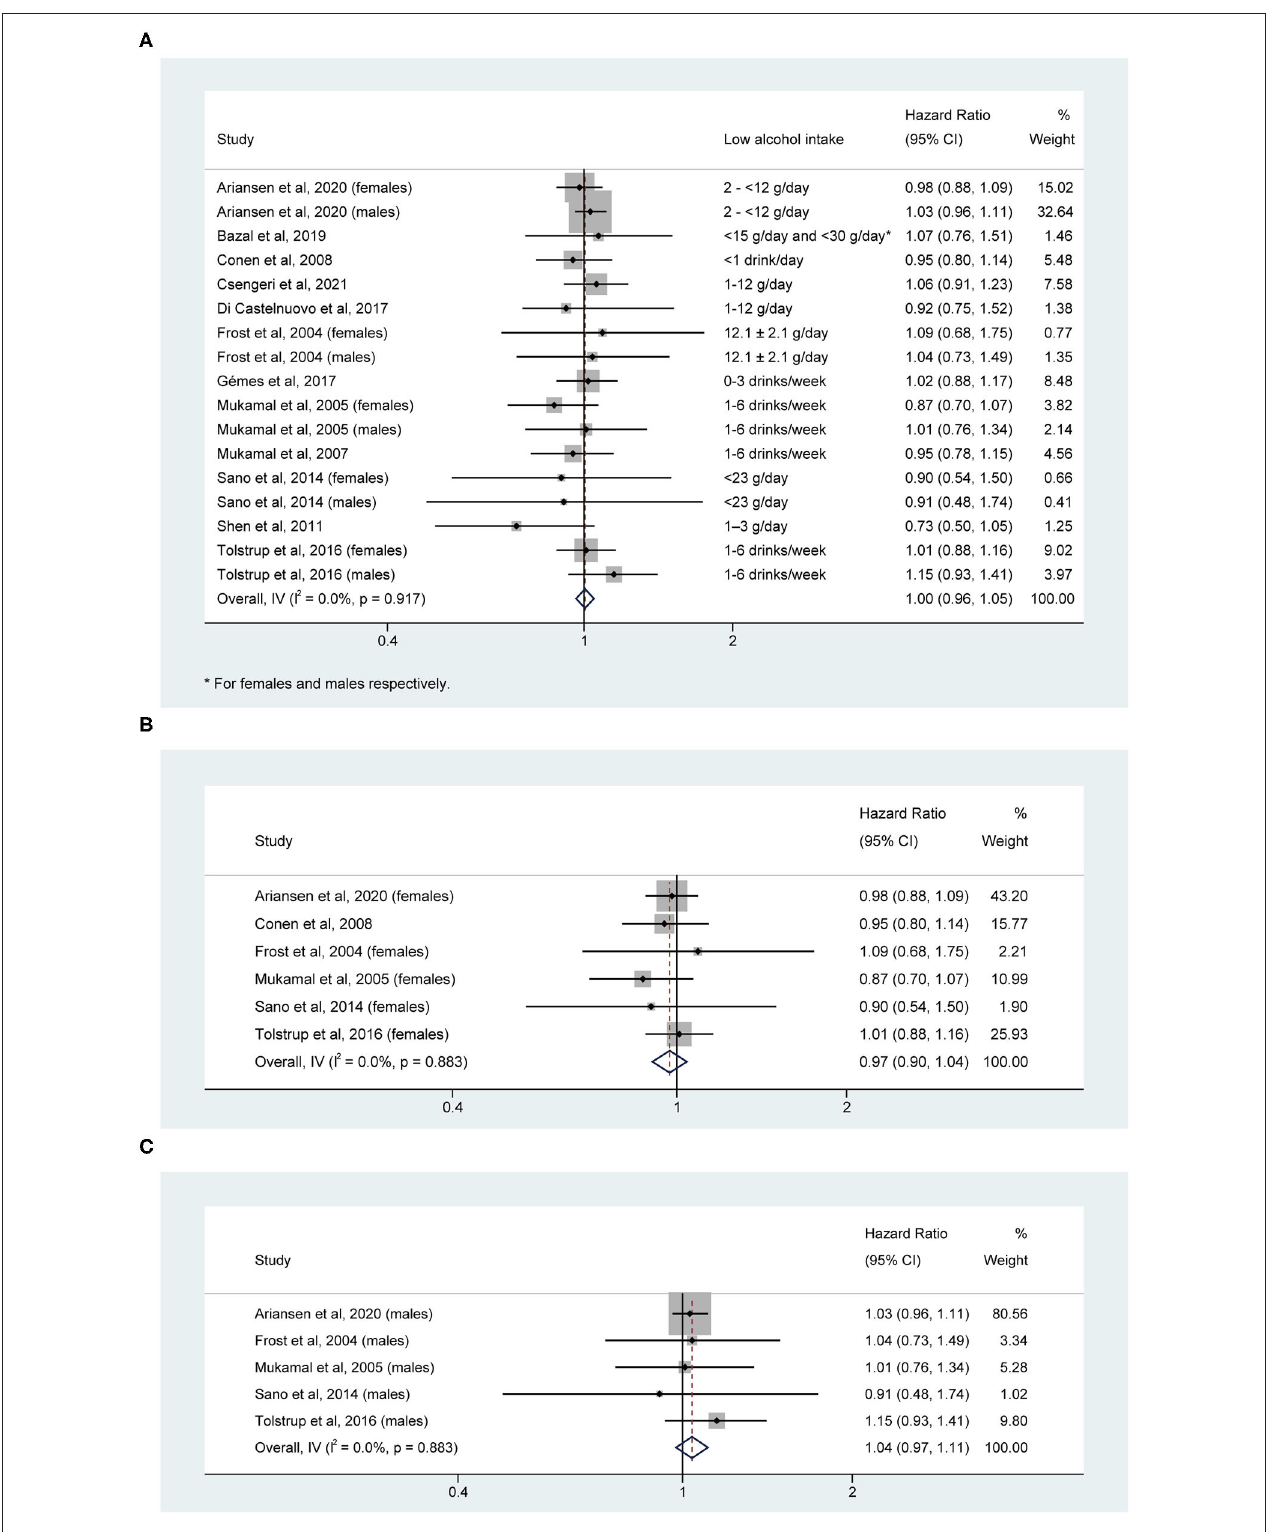
FIGURE 4 | Hazard ratios of the risk of atrial fibrillation for low alcohol intake in (A) overall, (B) female, and (C) male individuals.